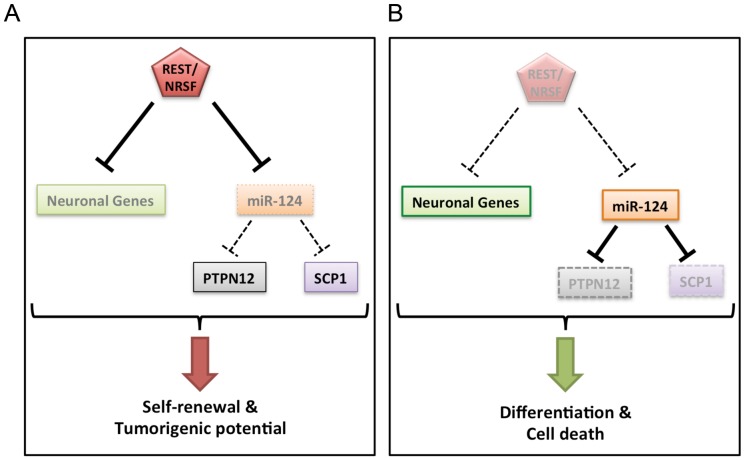
Schematic diagram illustrating one of the hypothetical regulatory mechanisms by which REST controls the cellular status in REST-expressing human tumorigenic-competent GBM cells (left box) and how this is perturbed in REST-depleted (right box) cells.